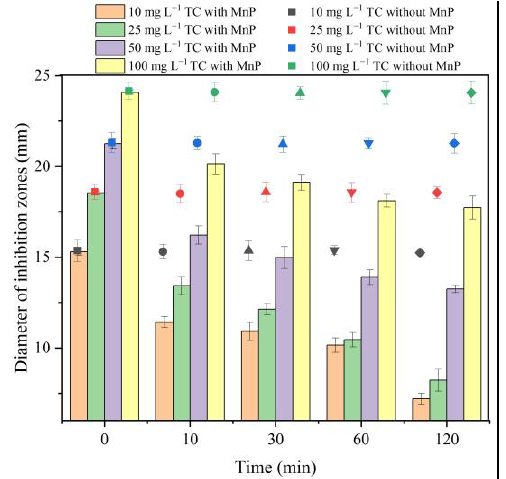
Figure 4. The antibacterial potency of the transformation products in MnP system were measured using inhibition zones. The inner diameter of the wells was 6 mm in the disk diffusion test.